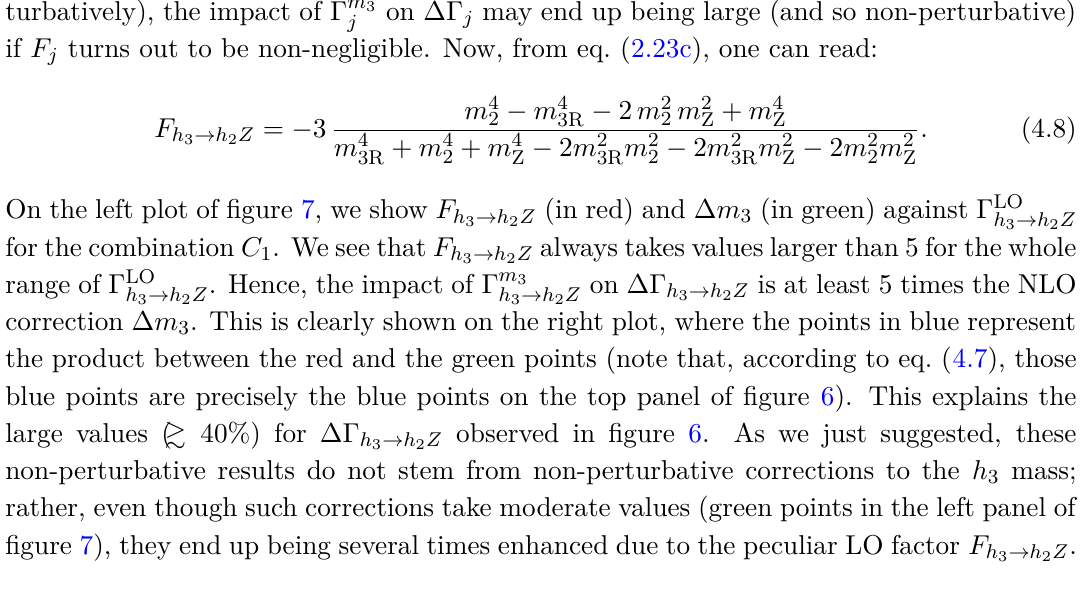
Figure 7. Left: F h (red) and ∆ m 3 (green) against Γ LO 3 → h 2 Z the same, but also with the product (blue) of the green and red